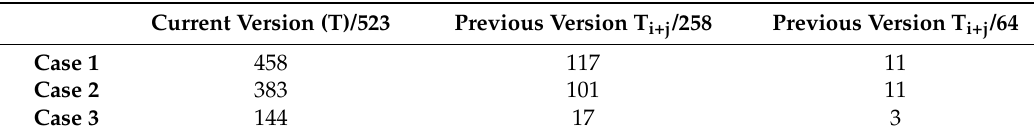
Table 11. Evolution of names of OSM subway